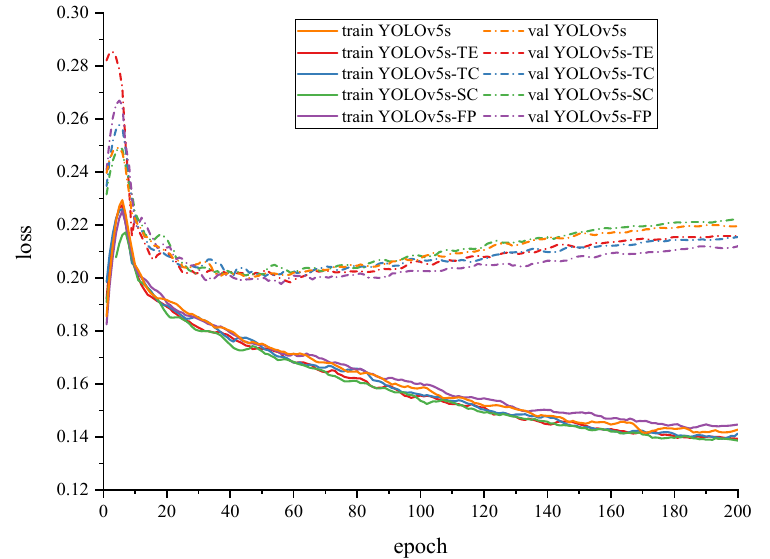
Figure 8. Comparison of coordinate loss of ablation experiments on the training and validation set.